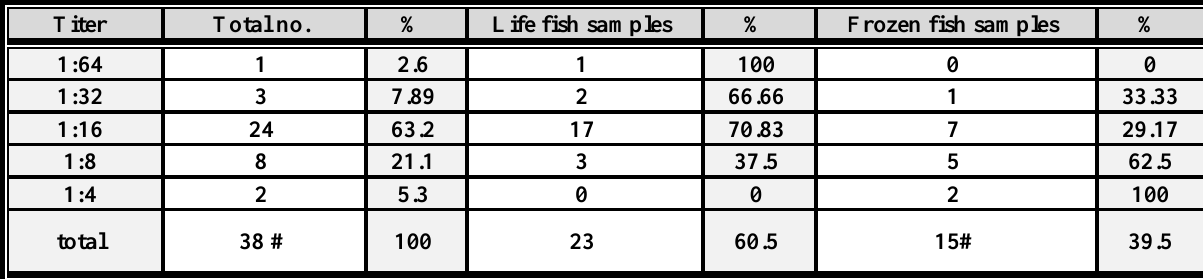
Table 2: The results of the cytotoxic effects of Aeromonas hydrophila on Vero cells Titer Total no. % Life fish samples % Frozen fish samples %